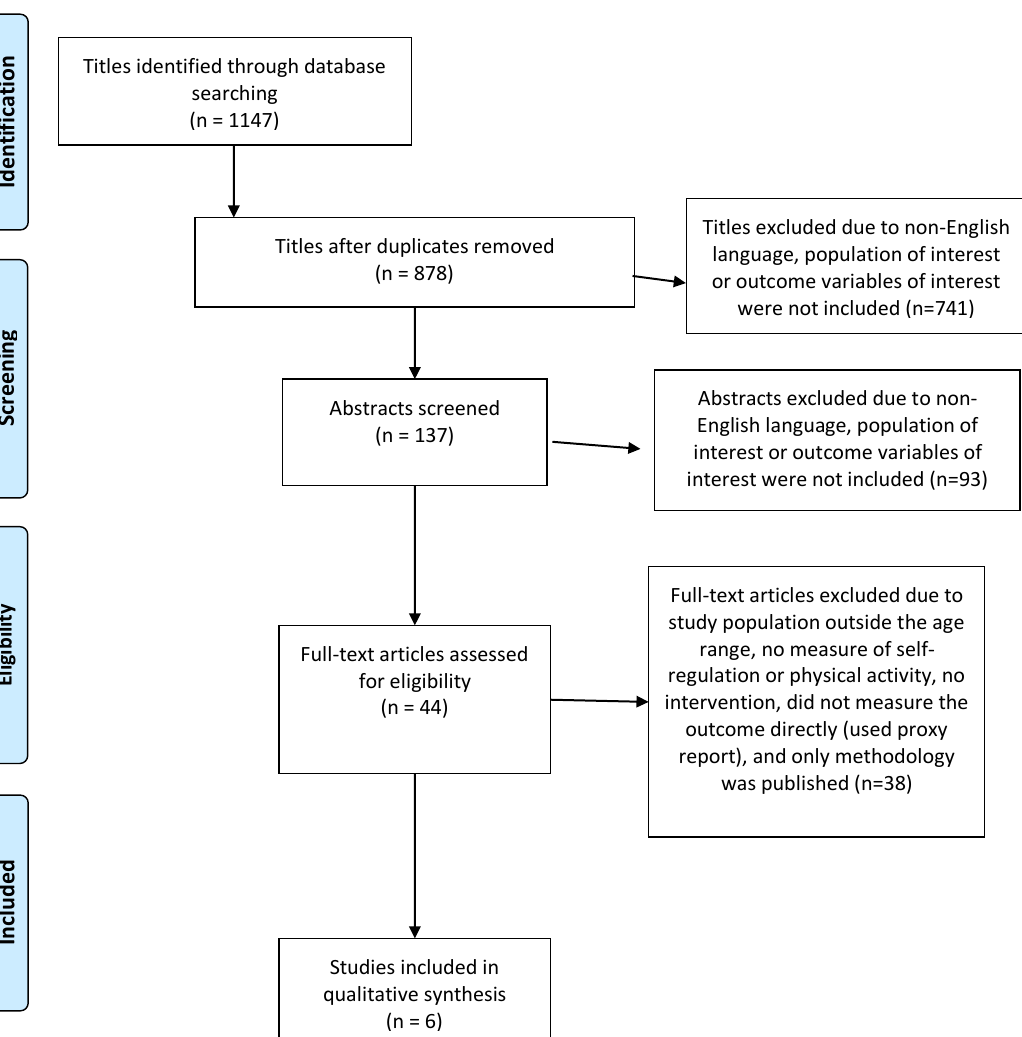
Figure 1. Study identification flow diagram. Figure 1. Study Identification Flow Diagram